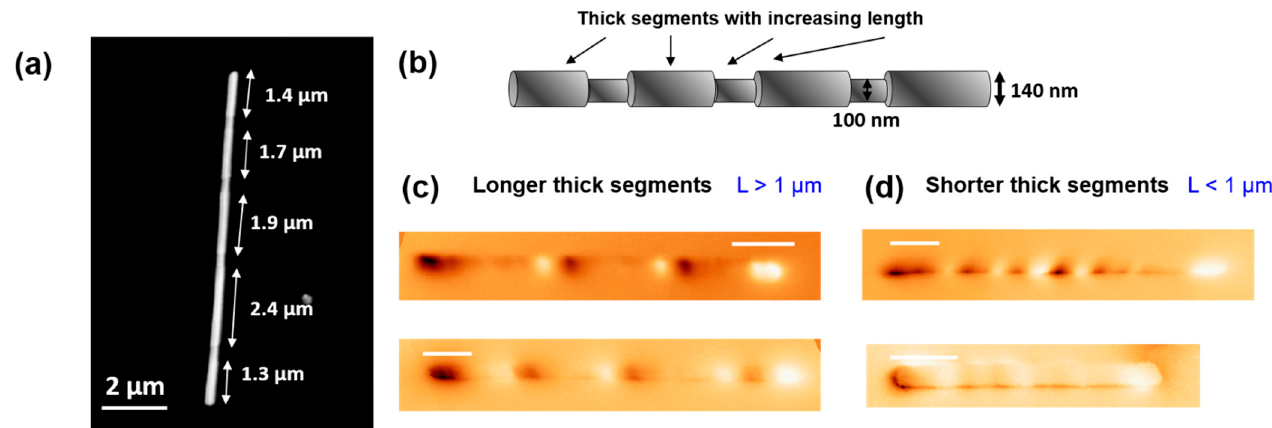
Figure 1 . ( a ) Atomic Force Microscopy (AFM) topography image of a typical studied nanowire and ( b ) illustrative sketch of the diameter modulated structure showing the increasing segment length of the thick segments. Magnetic Force Microscopy images at remanence state of ( c ) nanowires with longer thick segments and ( d ) NW with thick segments shorter than 1 μ m.